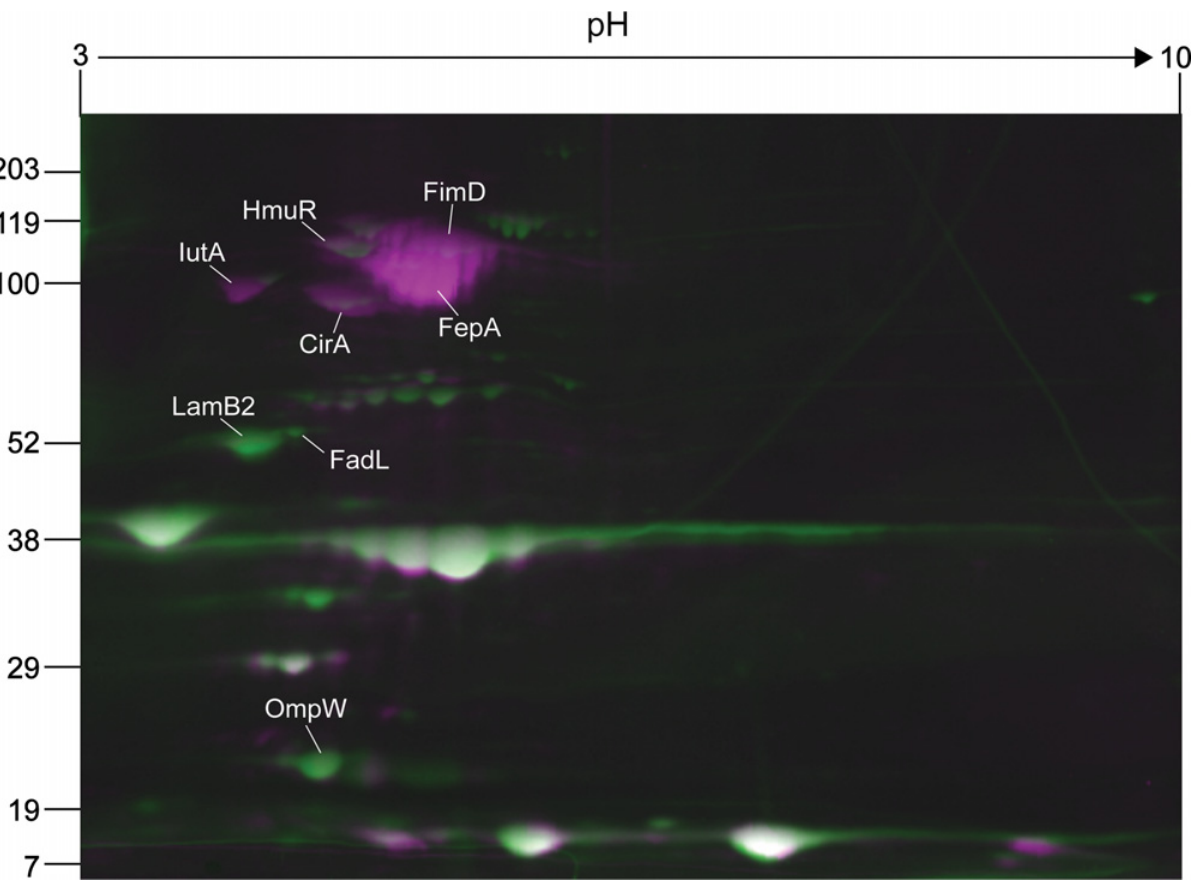
Fig 4. Comparison of outer membrane protein expression in LB and RPMI growth media. Representative 2D gels of stationary-phase outer membrane proteins expressed in LB (green) or RPMI (purple) were overlayed in Samespots software (Nonlinear Dynamics). White spots indicate colocalized proteins.